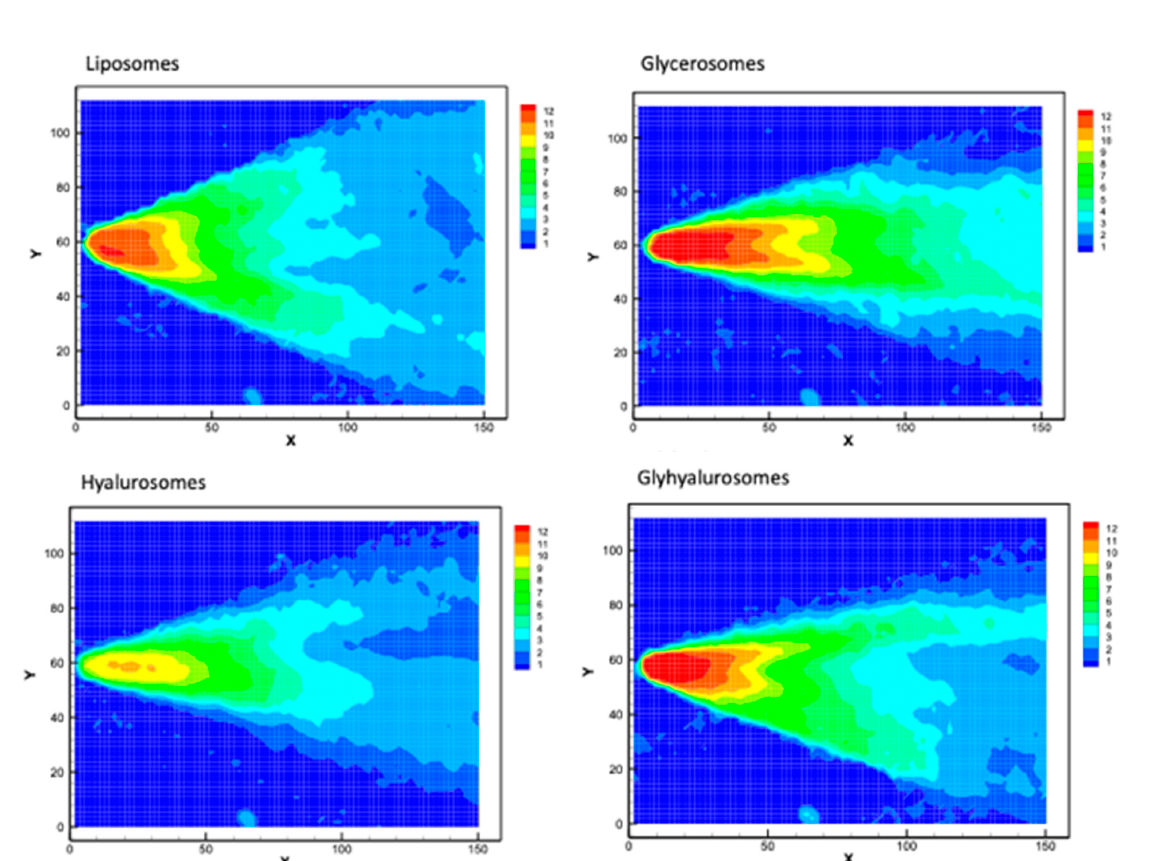
Figure 6. Images of modulus of average velocity of sprayed liposomes, glycerosomes, hyalurosomes and glyhyaluro- somes.